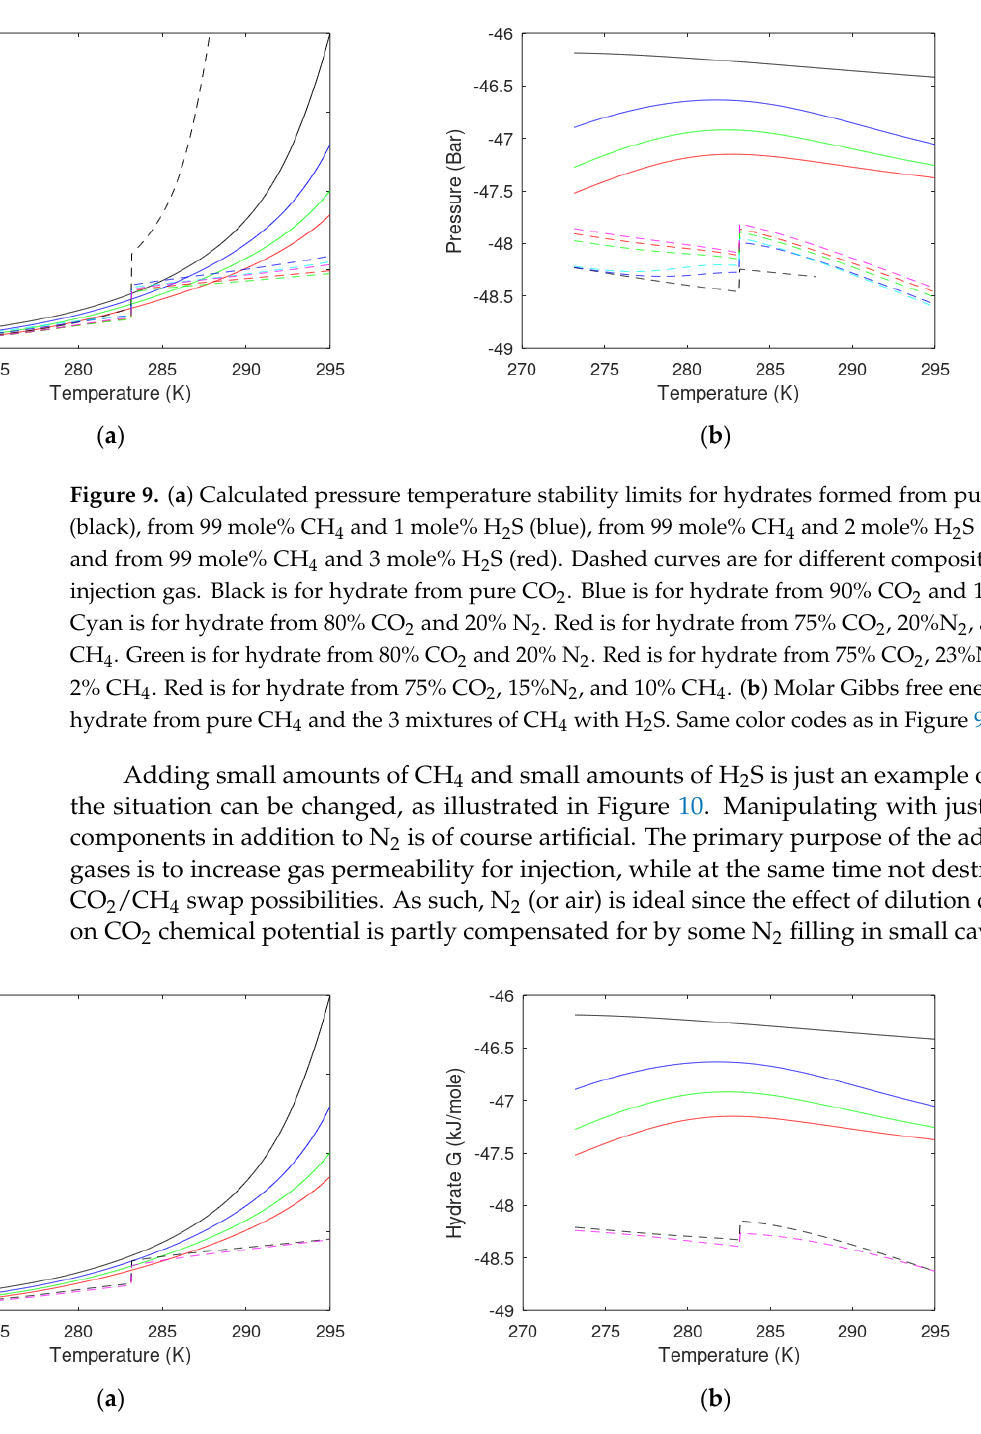
Figure 10. ( a ) Calculated pressure temperature stability limits for hydrates formed from pure CH 4 (black), from 99 mole% CH 4 and 1 mole% H 2 S (blue), from 99 mole% CH 4 and 2 mole% H 2 S (green), and from 99 mole% CH 4 and 3 mole% H 2 S (red). Dashed curves are for different compositions of injection gas. Red is for a mixture of 75 % CO 2 , 1 % H 2 S, 1% CH 4 , and 23% N 2 . Magenta is for a mixture of 75 % CO 2 , 2 % H 2 S, 3% CH 4 , and 20% N 2 . ( b ) Molar Gibbs free energy for hydrate from pure CH 4 and the 3 mixtures of CH 4 with H 2 S. Same color codes as in Figure 10 (a).